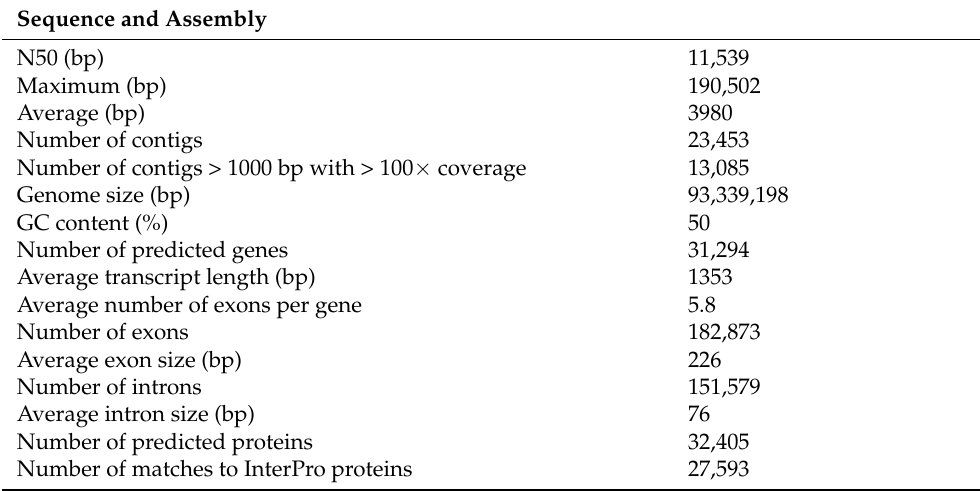
Table 2. Features of the Ceratobasidium C02